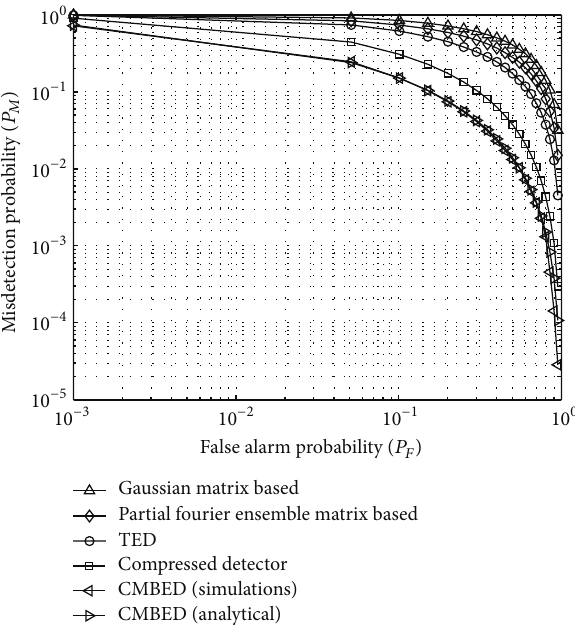
Figure 3: Complementary ROC when 𝑁 = 512 and 𝛾 = 15 dB.